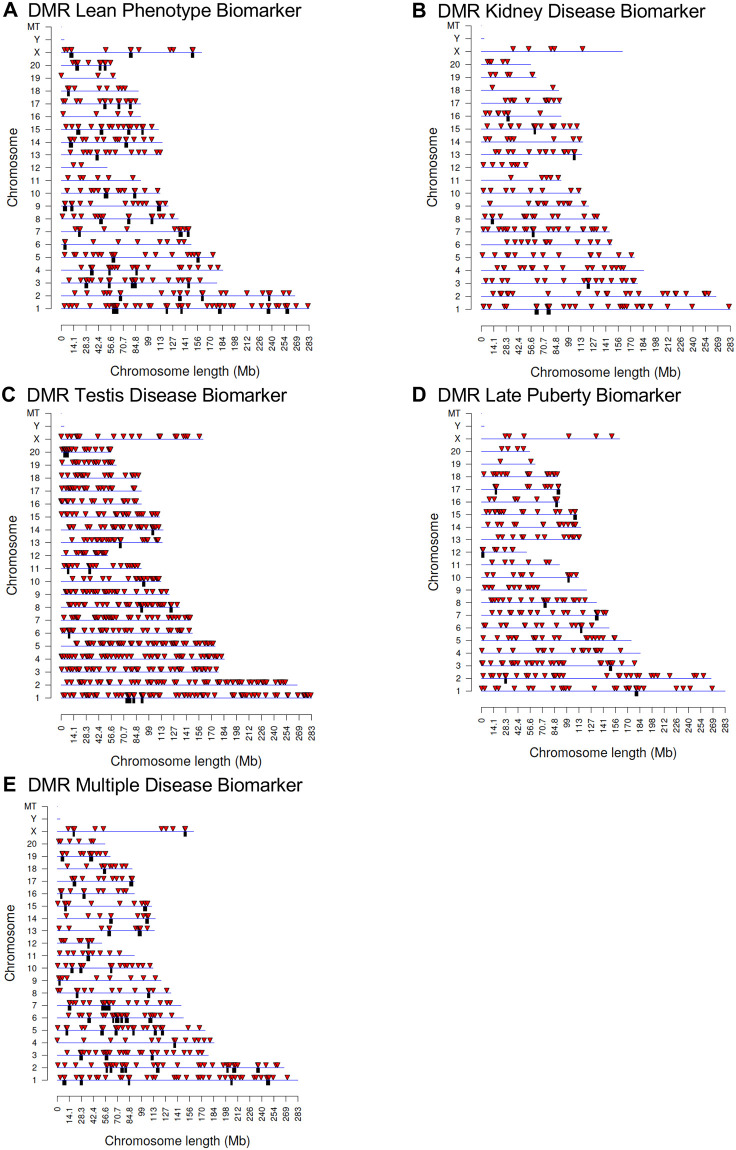
DMR chromosomal locations.The DMR locations on the individual chromosomes is represented with an arrowhead and a cluster of DMRs with a black box. All DMRs containing at least one significant window at a p-value threshold of p<1e-04 for DMR are shown. (A) Lean phenotype DMRs; (B) Kidney disease DMRs; (C) Testis disease DMRs; (D) Late puberty DMRs; and (E) Multiple disease DMRs. The chromosome number versus size (megabase) is presented.